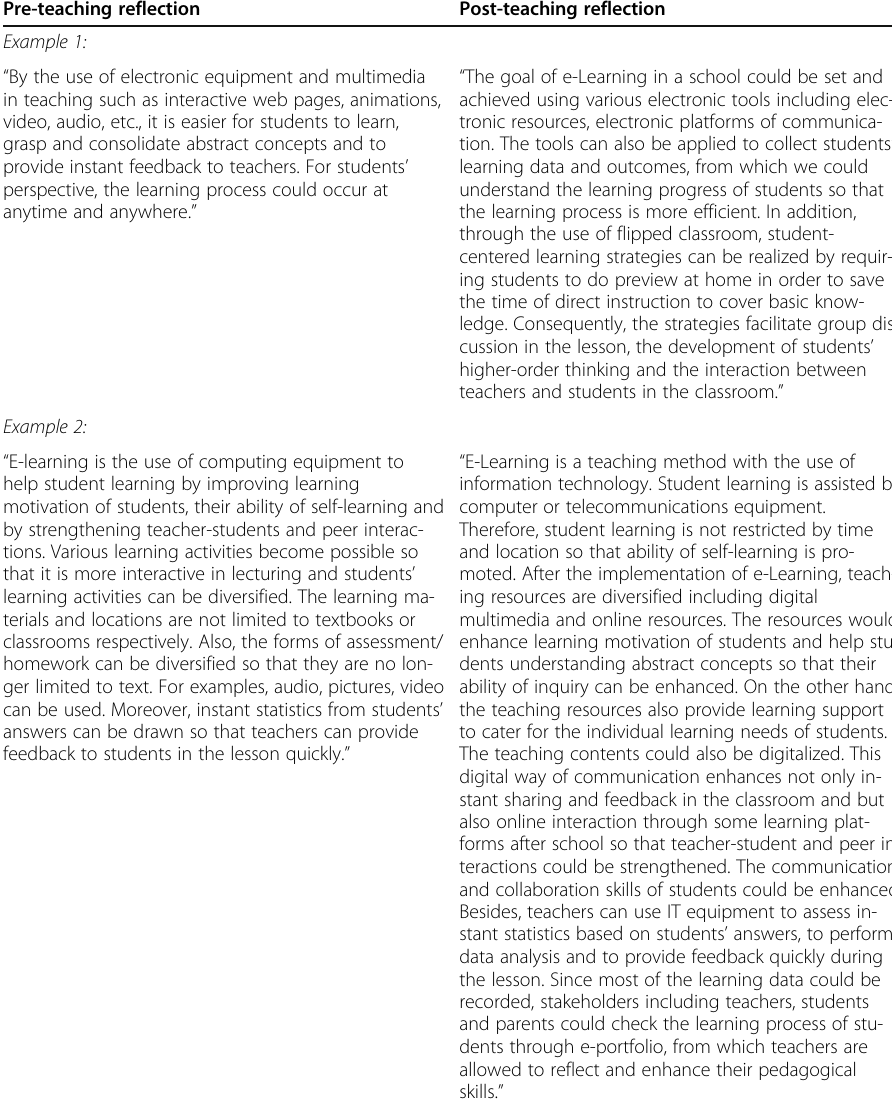
Table 4 Examples of learners ’ pre-teaching and post-teaching reflections on their understanding of